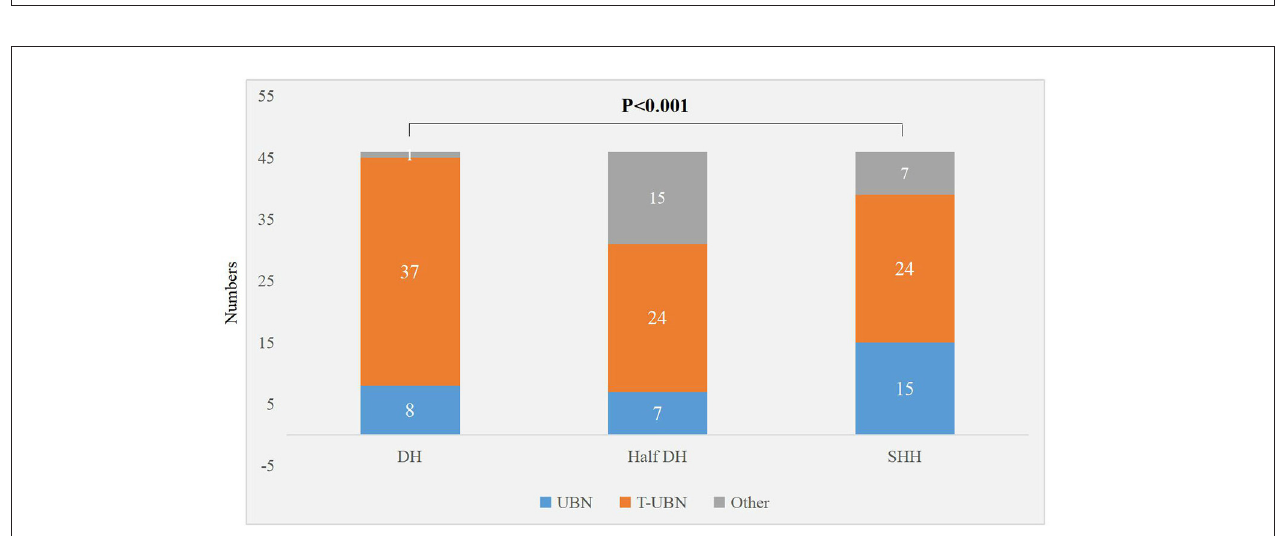
FIGURE 2 | Distribution of sit up and reverse nystagmus in three suspension positions in patients with PC-BPPV-cu.